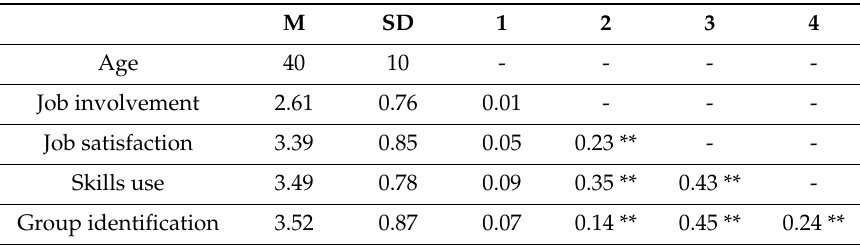
Table 1. Pearson correlation matrix.